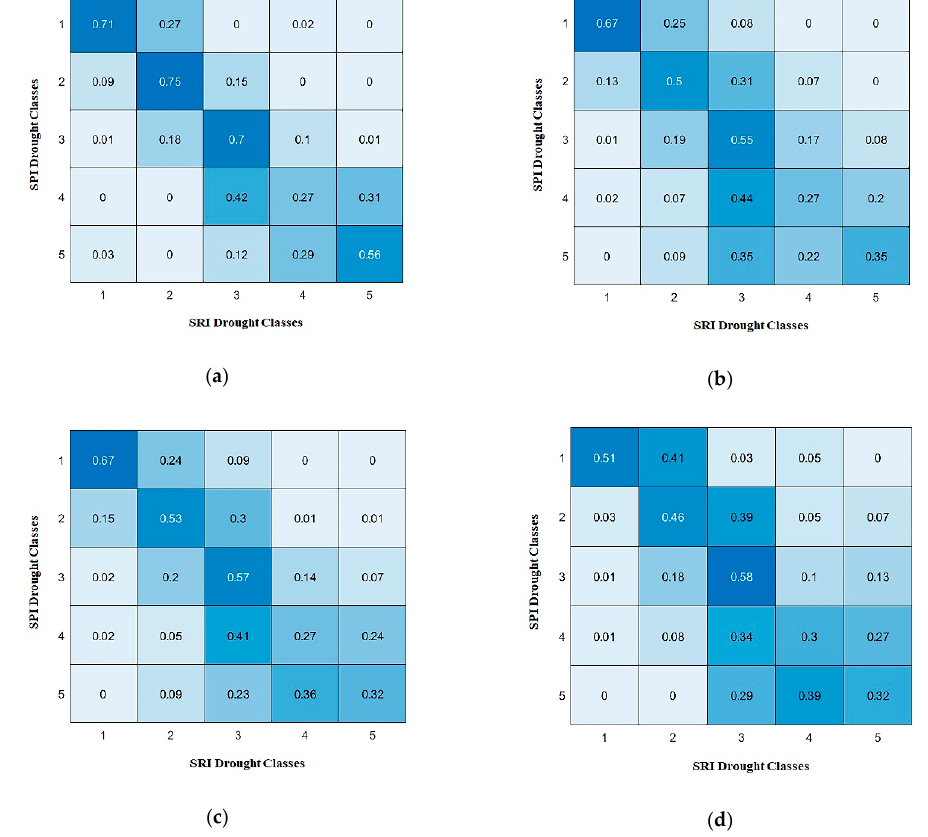
Figure 4. Propagation probability of each class of drought from SPI to SRI during 1967–2000. ( a ) Sub-basin #1003, ( b ) Sub-basin #1010, ( c ) Sub-basin #1012, ( d ) Sub-basin #1018.